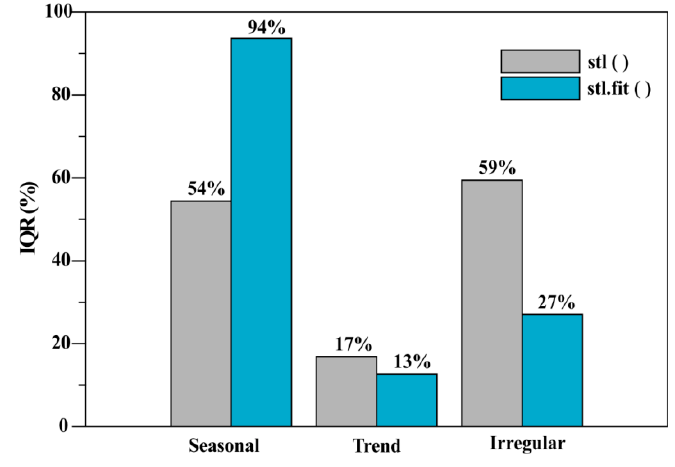
Figure 5. Comparison of the interquartile range (IQR) for the time series in Figure 4a,b.